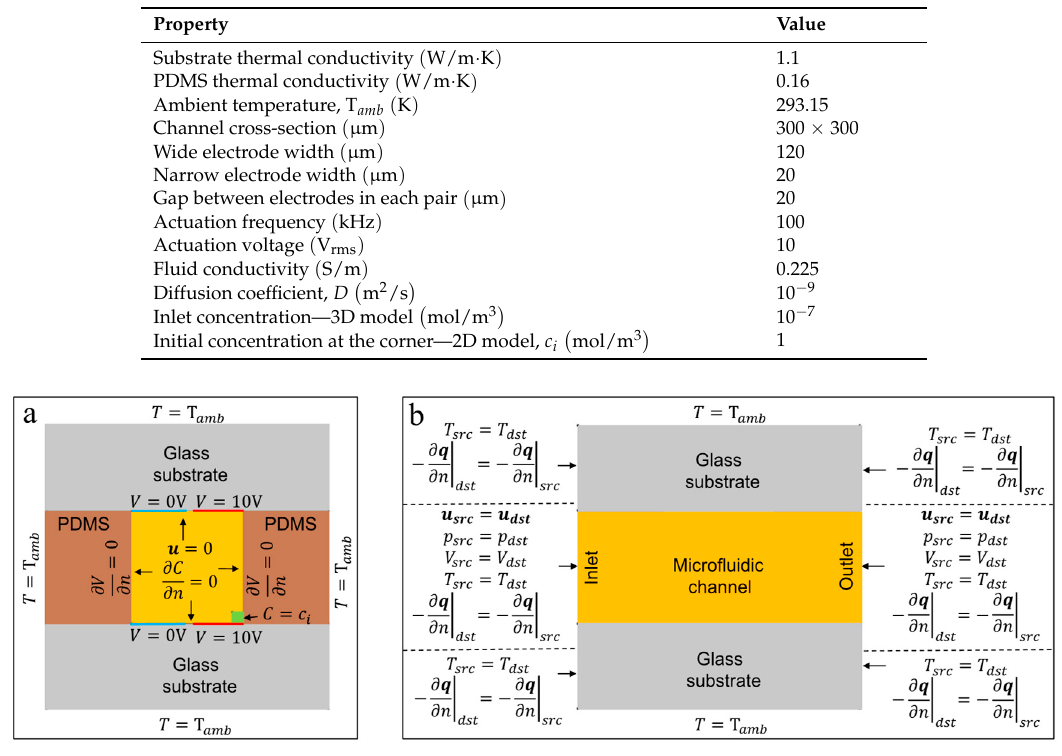
Table 1. Design parameters and fluid properties used in the numerical simulation.